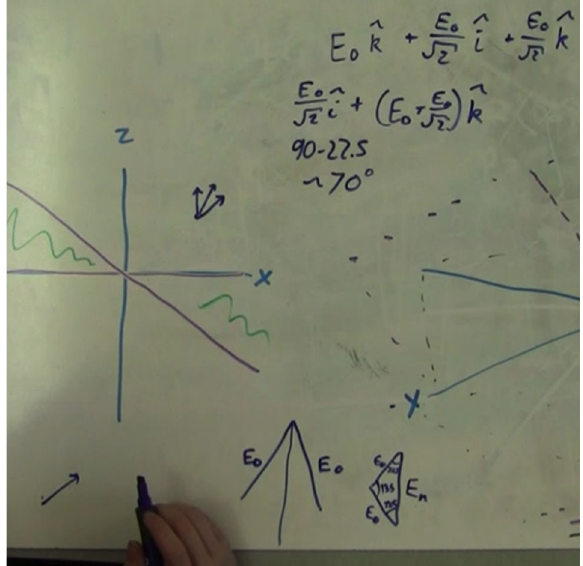
FIG. 7. Overview of Anne ’ s board while performing the superposition task, using both the vector-arrows representation (bottom, center) and an algebraic representation (upper